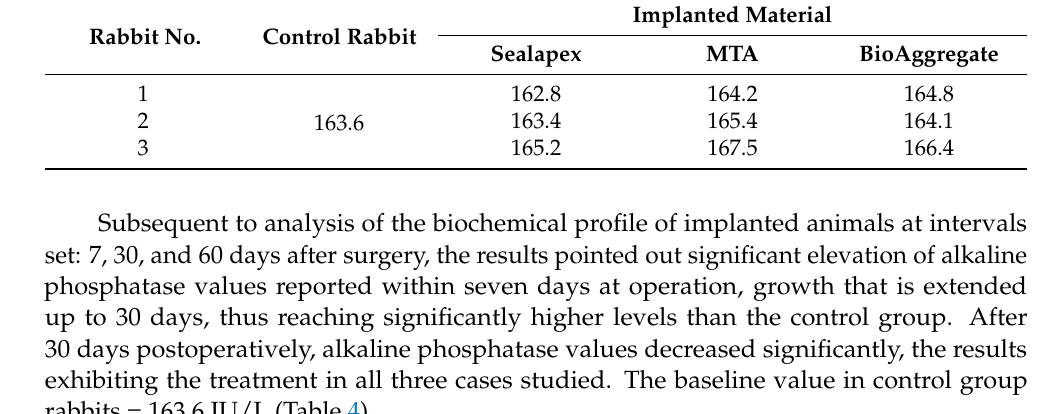
Table 3. Alkaline phosphatase values at 30 days postoperatively (IU/L). Rabbit No.